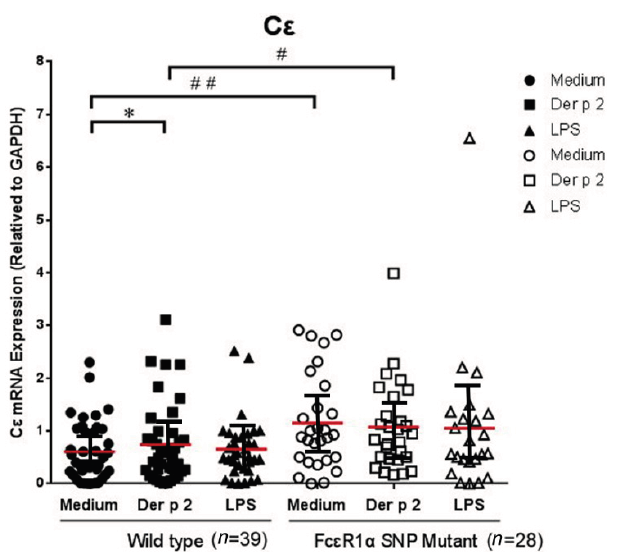
Figure 2. Genetic effect of genotypes rs2251746 ( − 95, T>C) and rs2427827 ( − 344, C>T) in the Fc ε R1 α promoter region on C ε mRNA expression. The PBMC were cultured with or without Der p2 for 48 h, followed by mRNA extraction. Values were presented as mean ± SEM. There were significantly higher levels of C ε mRNA expression in the PBMCs of subjects with SNPs of the Fc ε R1 α promoter region, regardless of Der p2 stimulation (* p < 0.05); # p < 0.05 when comparisons between the Fc ε R1 α promoter region SNPs (+) and SNPs ( − ) under Der p 2 (10 μ g/mL) induction; ## p < 0.05 when comparisons between the Fc ε R1 α promoter region SNPs (+) and SNPs ( − ) under medium condition. The effects of Der p2 on C ε mRNA expression were not affected by SNPs of the Fc ε R1 α promoter region. Wild-type: Patients with genotypes of rs2251746 ( − 95TT) and rs2427827 ( − 344CC) in Fc ε R1 α promoter region. Fc ε R1 α SNP Mutant: Patients with genotypes of rs2251746 ( − 95TC) and rs2427827 ( − 344TT/TC) in Fc ε R1 α promoter region.